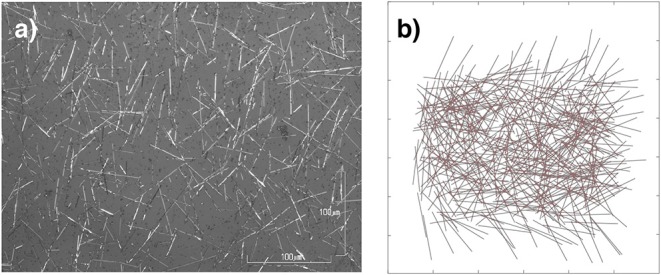
Neuromorphic nanowire networks. (a) Optical microscopy image of an actual self–assembled network of nanowires. The length of wires varies from~6 to 50μm in this image. (b) Simulated 500 nw (6,065 junction) network generated by our model. The length of wires in the simulated networks varies from 6 to 9μm.